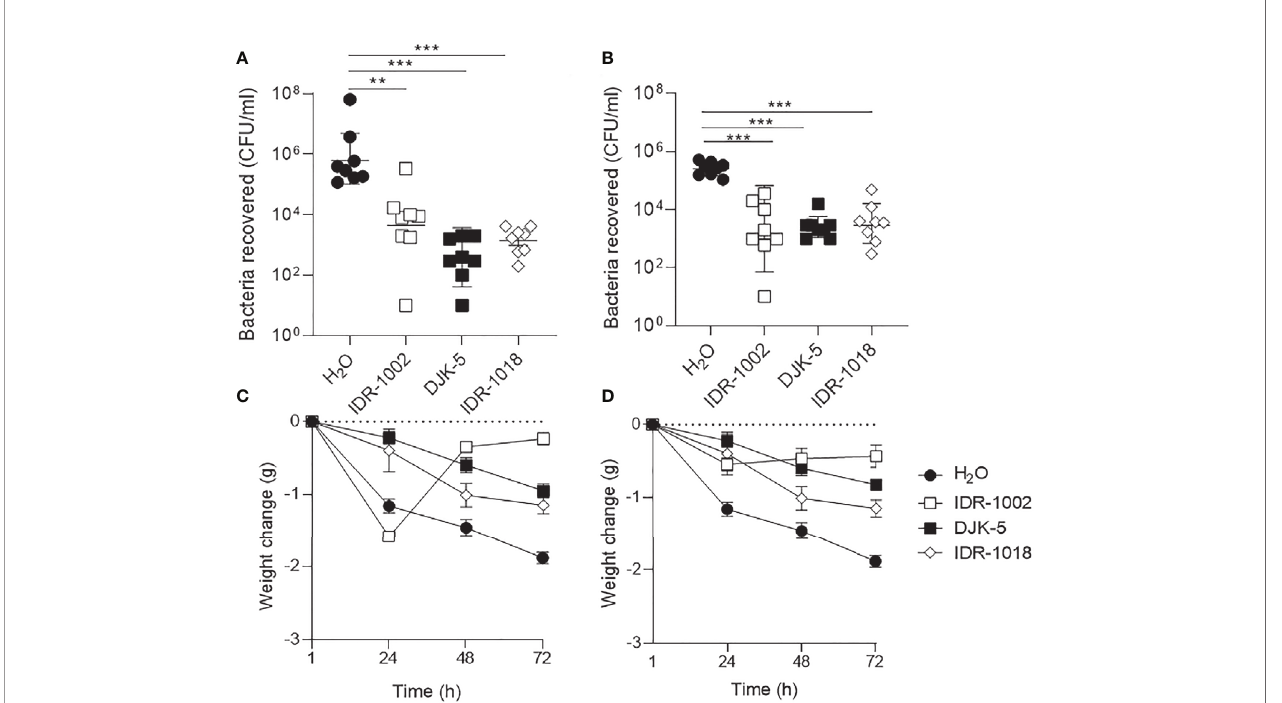
FIGURE 3 | Host-defense peptides reduced bacterial load in nasal cavity and stabilize weight loss following infection. (A, C) S. aureus USA300-Lux or (B, D) P. aeruginosa LESB58-Lux were inoculated dropwise in the left naris of C57Bl/6 mice (10 7 or 10 6 CFU, respectively). Mice were intranasally treated with endotoxin-free water (vehicle) or peptide (7.5 mg/kg or 2.5 mg/kg for DJK-5) 24-h post-infection. Forty-eight hours later, mice were euthanized and bacteria in the nasal cavity were collected by lavage. (A, B) All peptides reduced bacterial burden of the sinuses approximately 100-fold across species. (C, D) Peptide treatment stabilized weight loss or promoted weight gain following infection across species, whereas mice treated with endotoxin-free water continued to lose weight over time. n = 8. Data are presented as geometric mean ± SD. ** P < 0.01, *** P < 0.001 according to Mann-Whitney